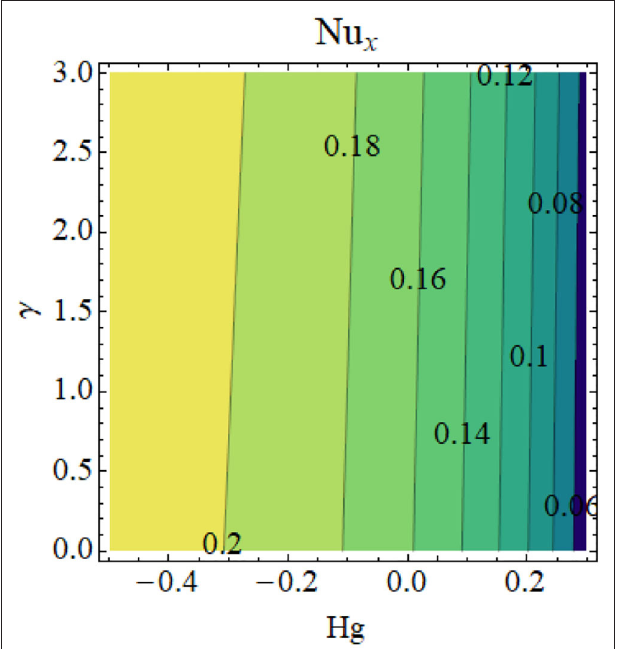
FIGURE 11 | Effects of Nt and M on Sh x . TABLE 2 | Validation of